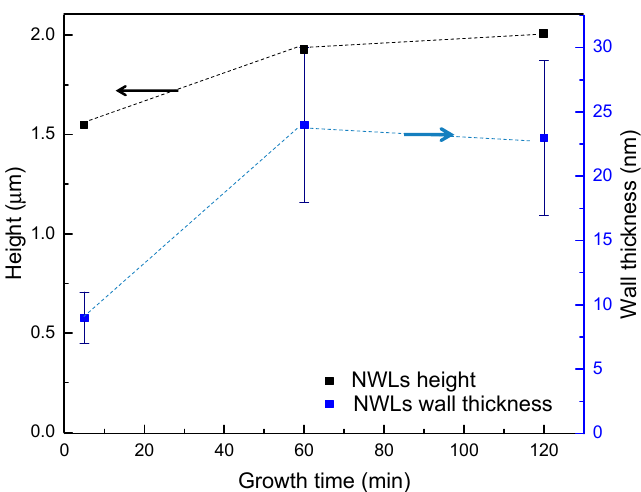
Figure 4. Average height (black squares, left black axis) and thickness (blue squares, right blue axis) of the ZnO nanowalls as a function of the growth time.